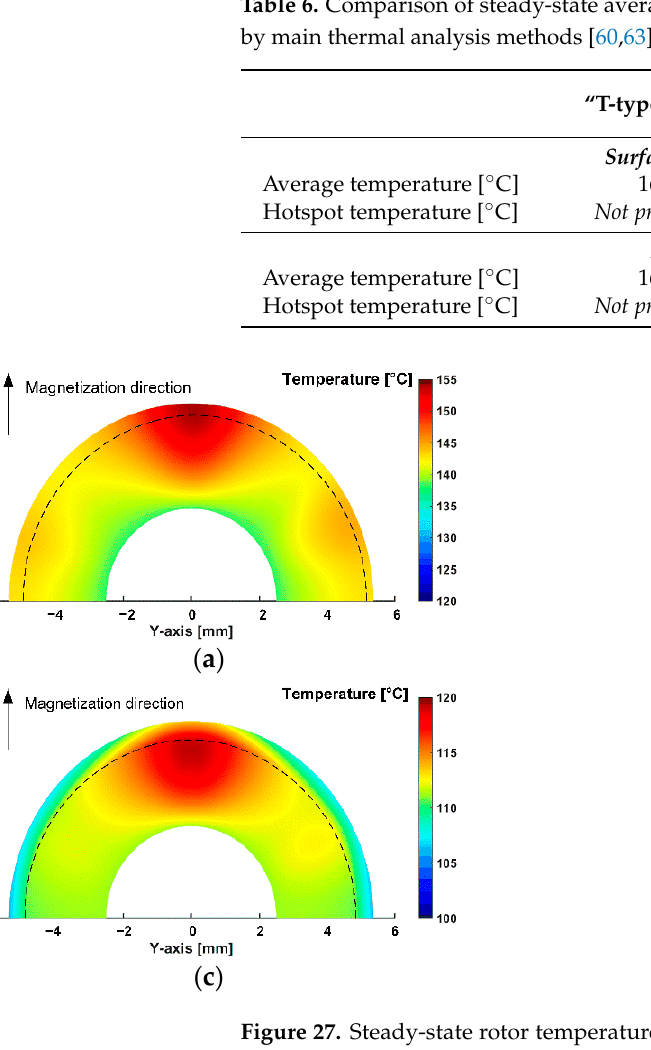
lines are the interface between PM and sleeve). ( a ) Stainless steel (analytical). ( b ) Stainless steel (FEA).